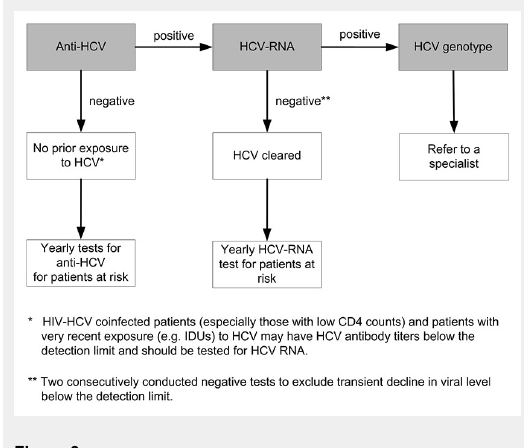
Testing for chronichepatitis C virus (HCV) infection: chronic HCV infection is defined as two consecutive positive HCV ribonucleic acid (RNA) tests at intervals of at least 6 months. IDU = intravenous drug